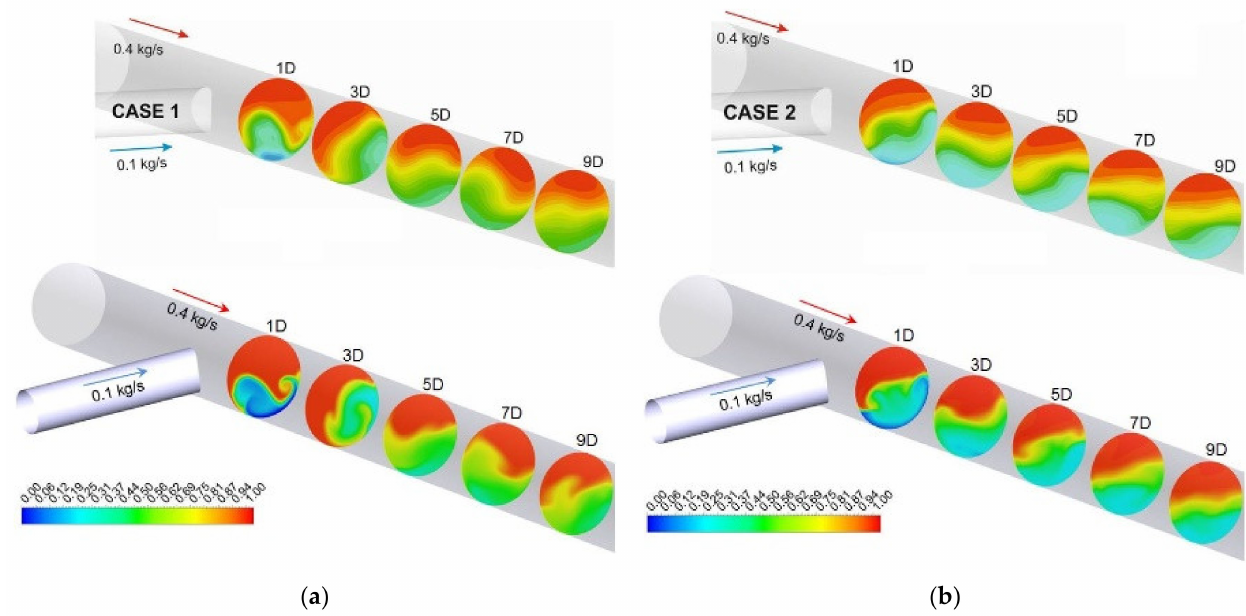
Figure 12. Variation of the dimensionless temperature T * in different sections downstream behind the mixing zone: ( a )—ST1, Table 2 (top figure—LES results [12], bottom figure—RANS results); ( b )—ST2, Table 2 (top figure—LES results [12], bottom figure—RANS